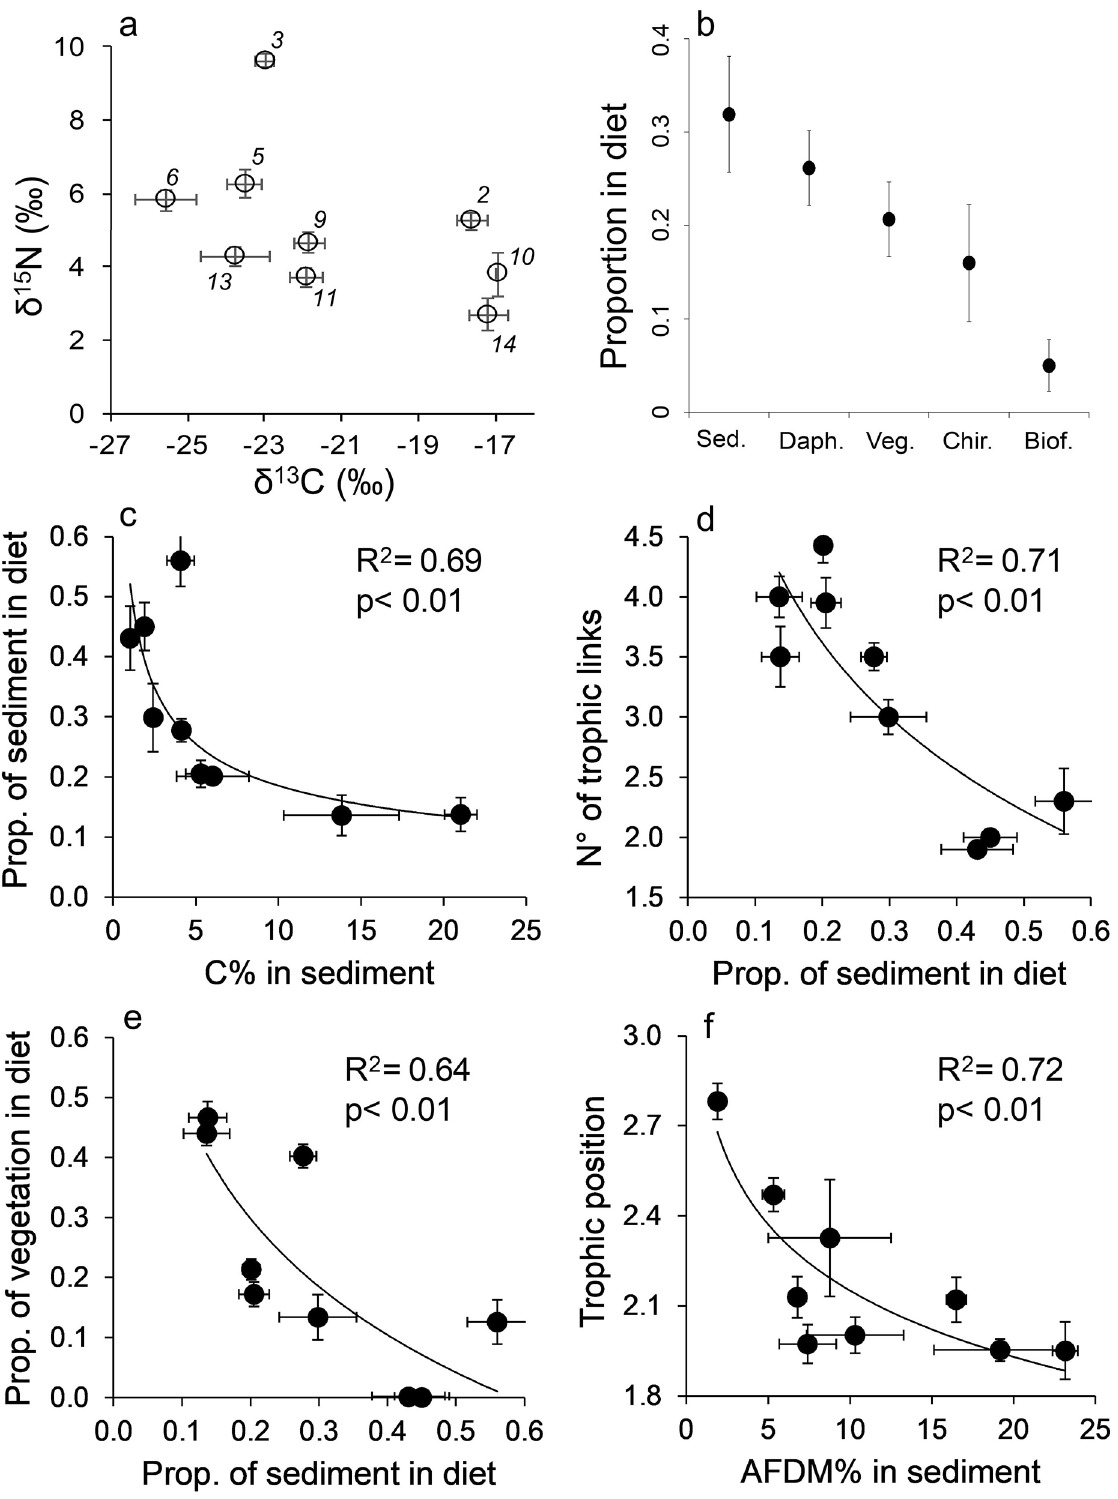
Figure 5. ( a ) Mean (± standard error among individuals) δ 13 C and δ 15 N values in Lepidurus arcticus (Notostraca). Numbers close to symbols indicate the lake number as reported in Table 1. ( b ) Mean (± standard error among lakes) proportional contribution of various food sources to the diet of L. arcticus , obtained through individual Bayesian isotopic mixing models (MixSIAR in R software). “Sed”: sediment, “Daph.”: Daphnia pulex , “Veg.”: benthic vegetation, “Chir.”: chironomid larvae, “Biof.”: biofilm. ( c , d ) Correlations between C and ash free dry matter content (AFDM), as %, in lake sediment and the trophic niche and position of Lepidurus arcticus . “N° of trophic links” refers to the number of distinct food sources that contributed to the diet of L. arcticus within each